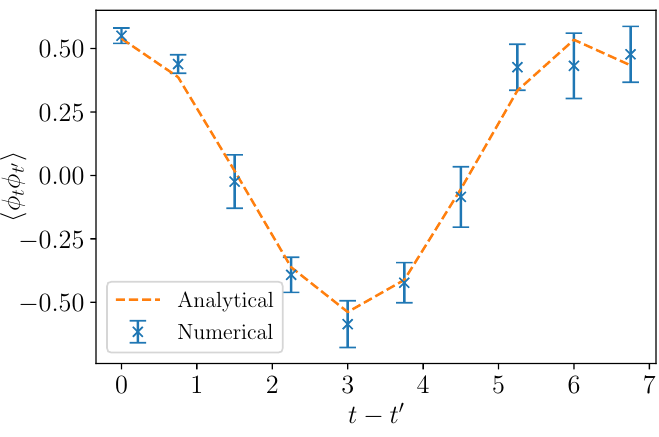
Figure 5. The correlator eq. (3.5) for a single free